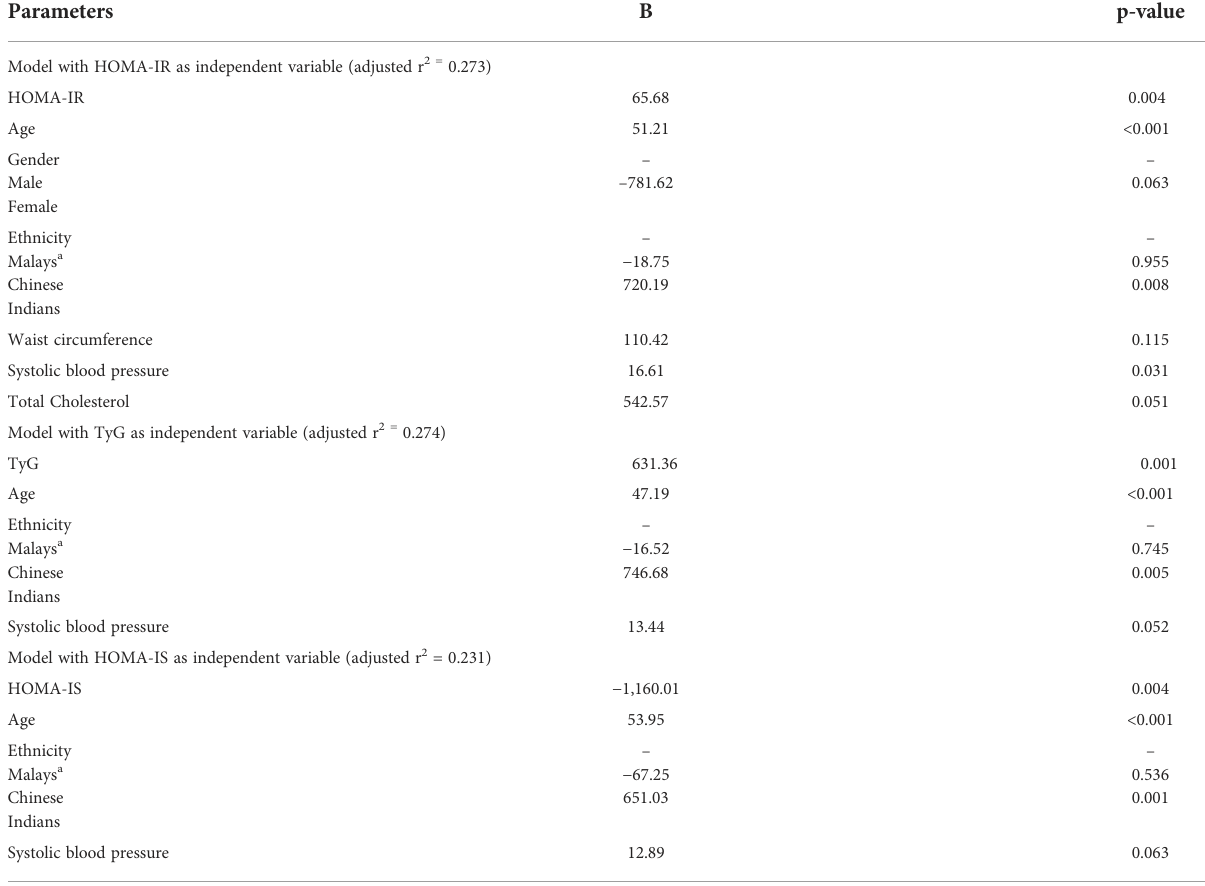
TABLE 5 Multiple linear regression analysis of AUC GLP-1, with HOMA-IR, TyG, HOMA-IS, and other independent variables.